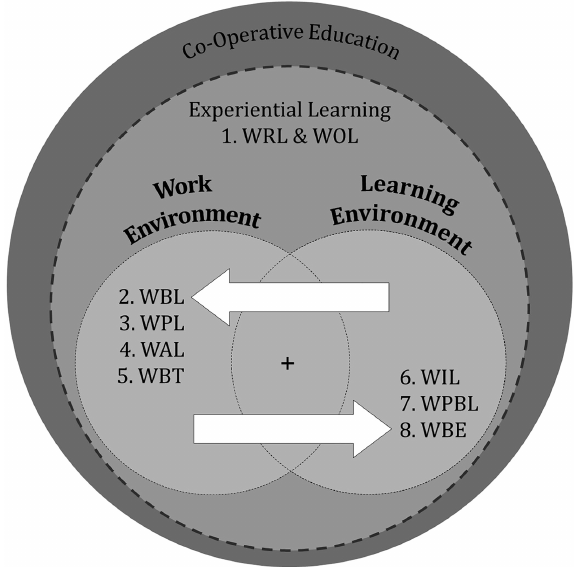
Figure 1. Proto-theoretical